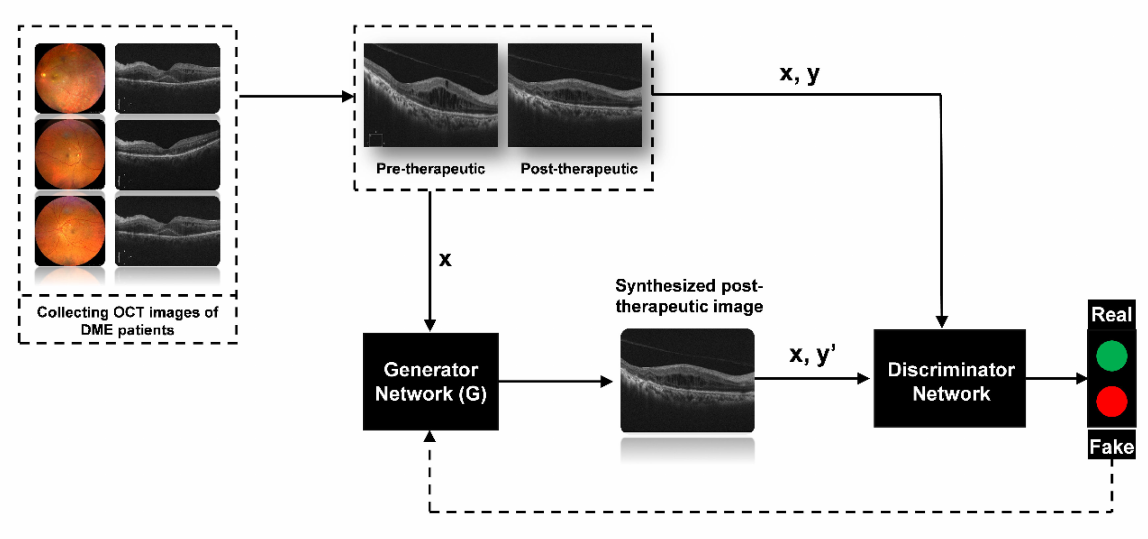
Figure 3. Illustration of generating post-therapeutic OCT from pre-therapeutic OCT by the GAN. OCT, optical coherence tomography; GAN, generative adversarial